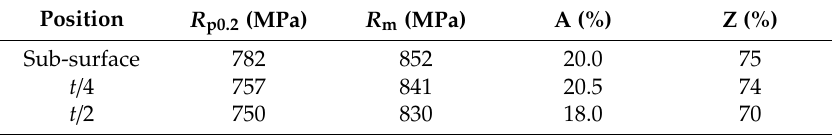
Table 2. Tensile properties of the different thickness positions of the experimental steel.